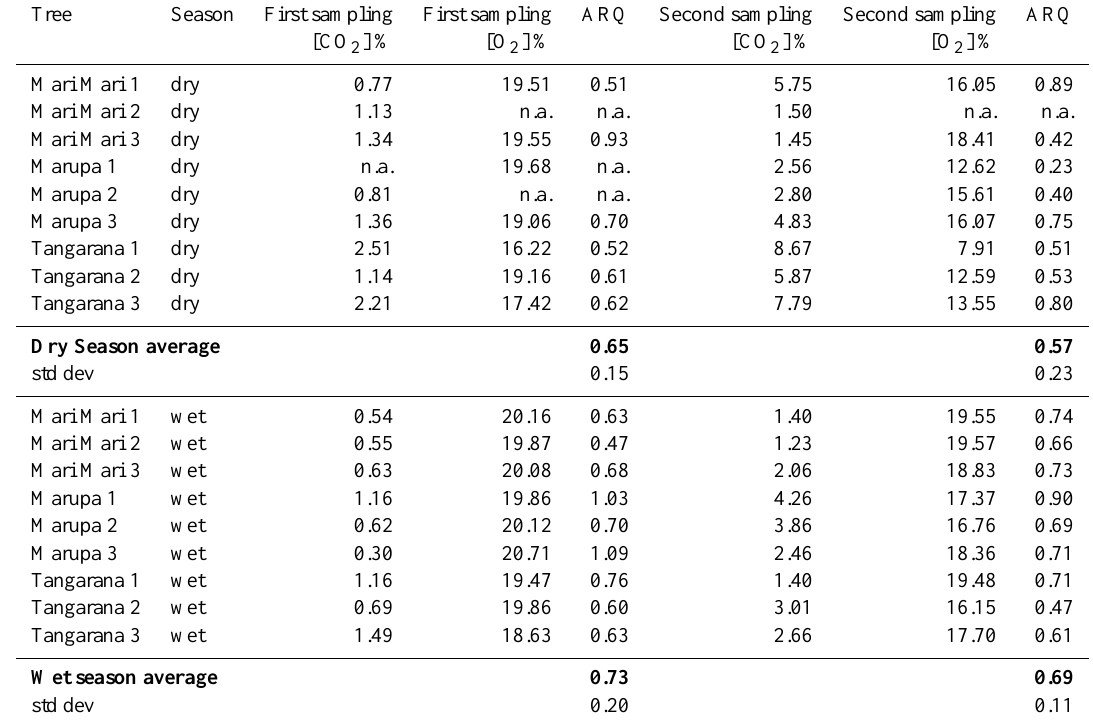
Table 3. Results of the stem chambers experiments. First sampling: 2–3h after the start of the experiment in the dry season, 6–8h in the wet the text. The analytical error in ARQ estimate is 0.02, on average, in the dry season and 0.03 in the wet